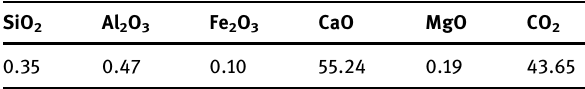
Table 1: Chemical composition of limestone, wt%